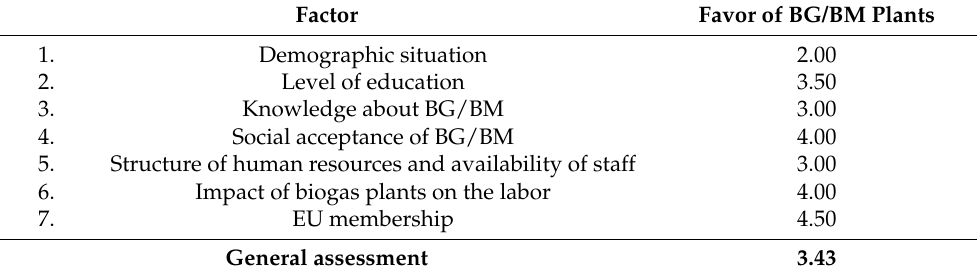
Table 6. Social environment of BG/BM plants in Poland in the context of their development